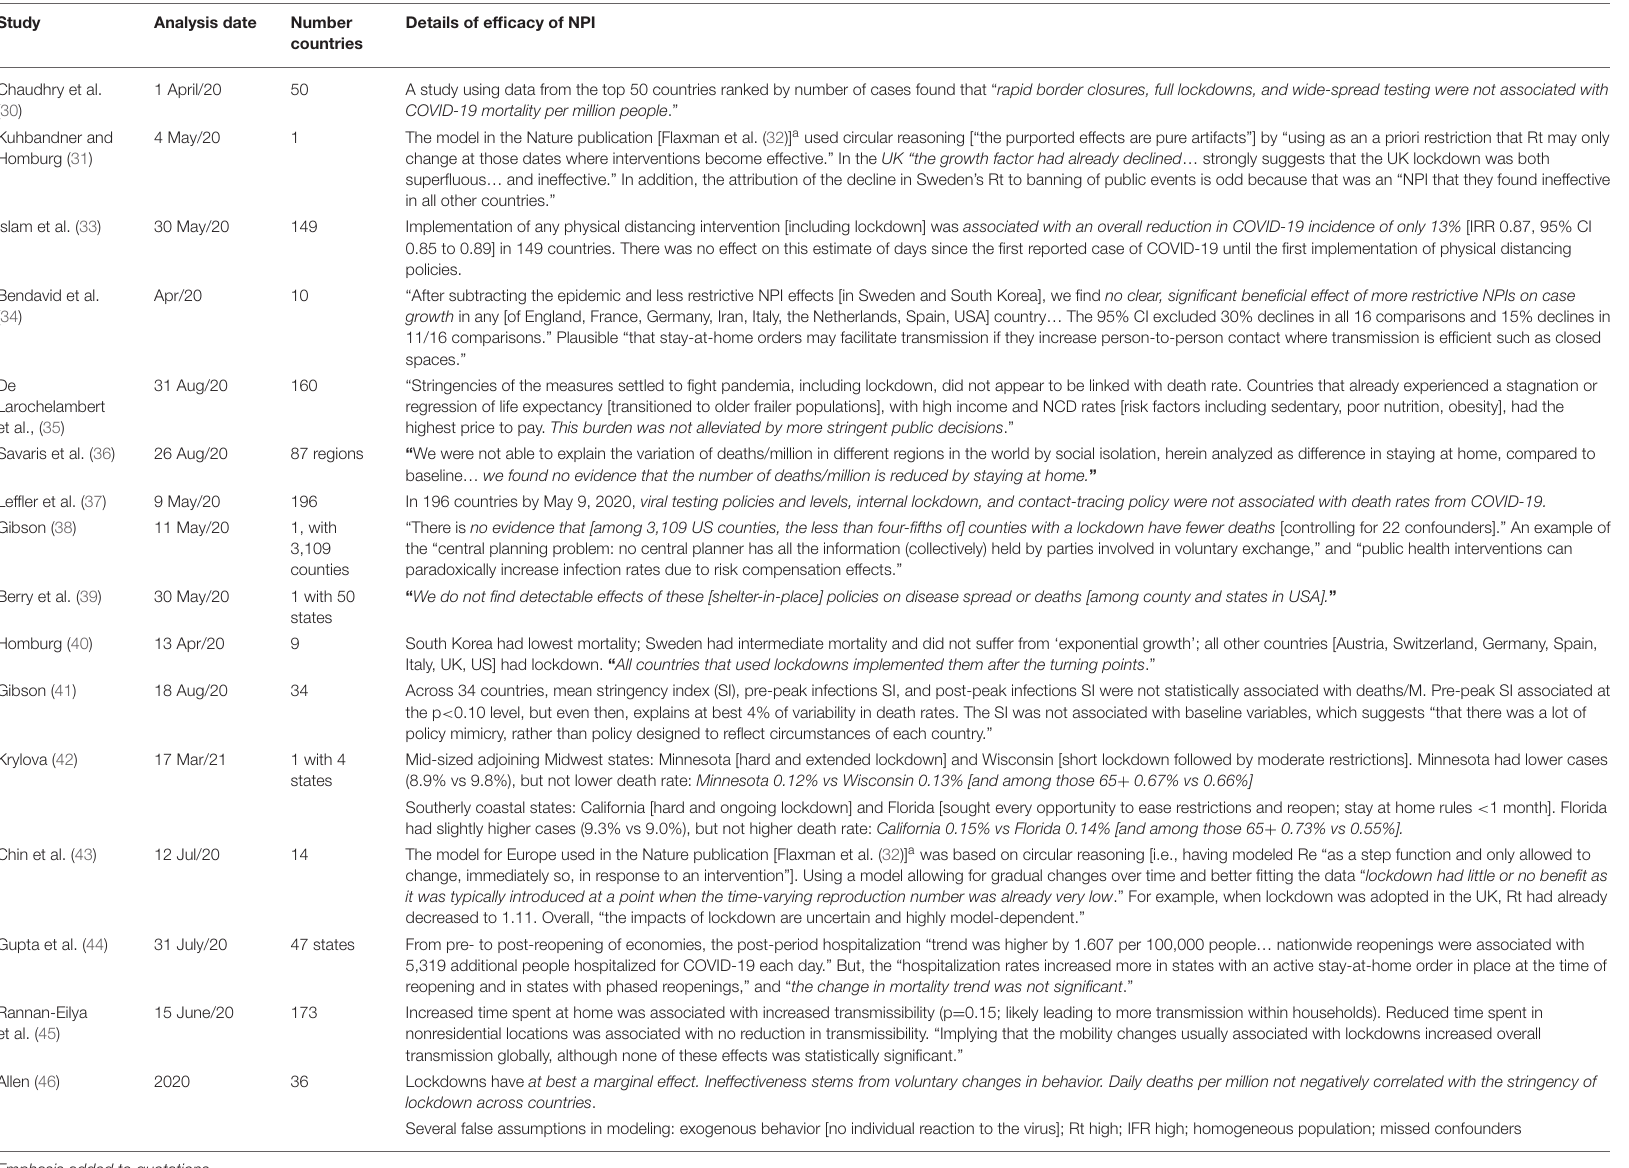
TABLE 3 | Peer reviewed published studies suggesting that efficacy of nonpharmaceutical interventions (lockdowns) to prevent spread of COVID-19 are at best highly exaggerated.